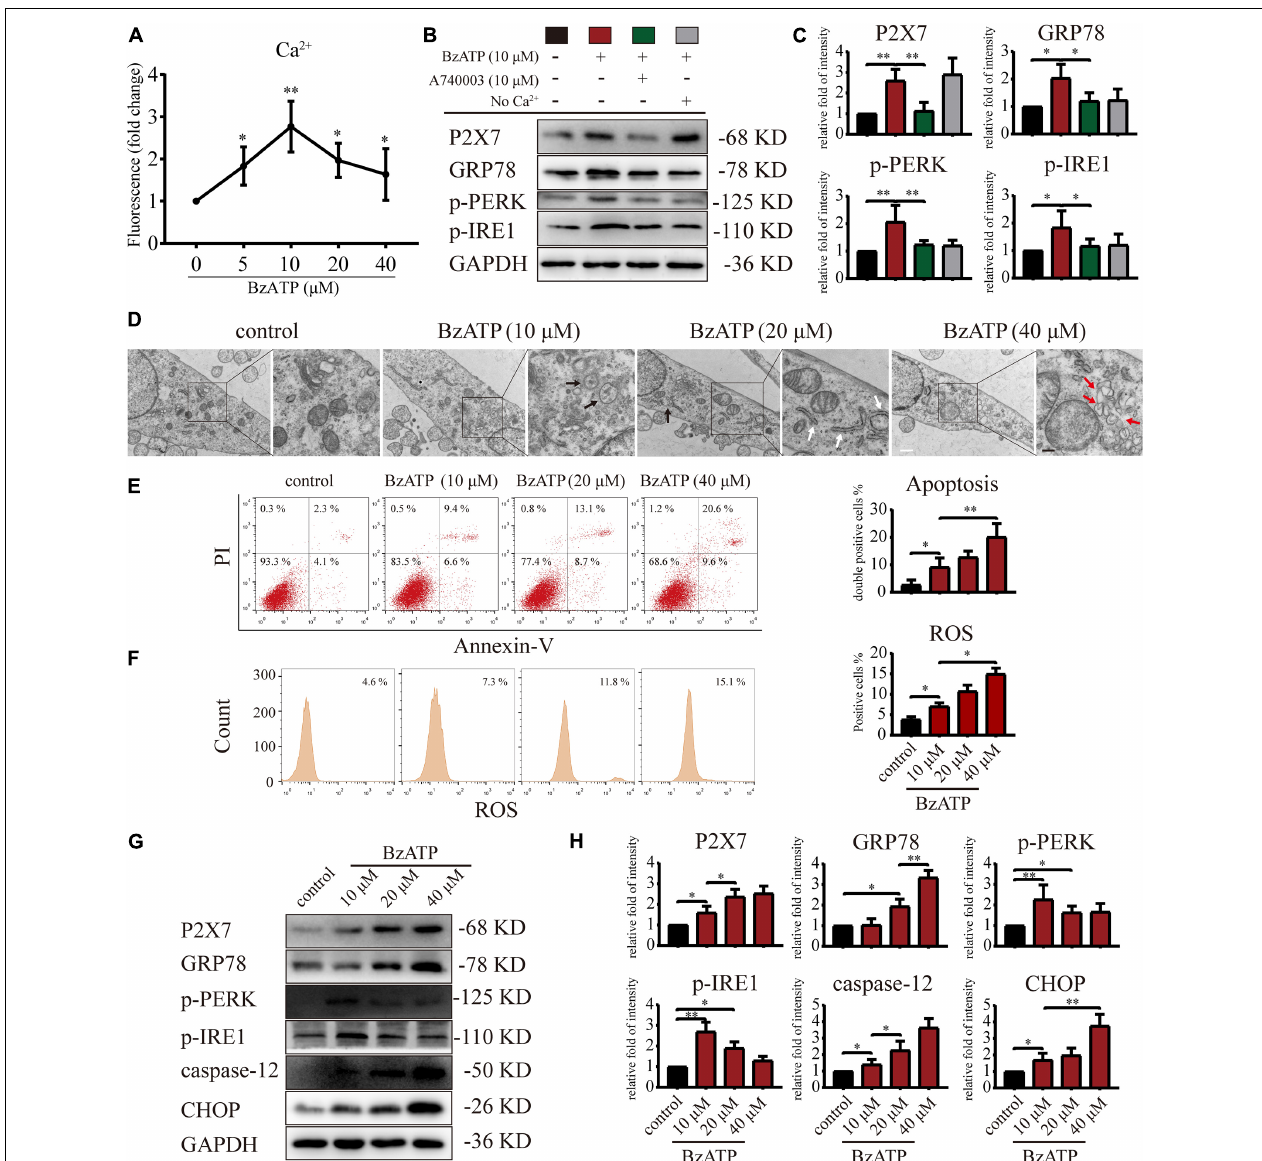
FIGURE 3 | P2X7 activation triggers Ca 2 + overload and induces ER stress. (A) Cells were cultured with different concentrations of Bz-ATP (0, 5, 10, 20, and 40 µ M), the fluorescence signal was detected by the microplate reader, and the Ca 2 + content in the ER was determined. (B,C) Cells were cultured with 10 µ M Bz-ATP, 10 µ M A740003, or Ca 2 + -free medium as described in section “Materials and Methods.” Western blotting was used to detect the protein levels of P2X7, GRP78, PERK, and IRE1. (C) Quantification of western blotting results. (D) Cells were cultured with different concentrations of Bz-ATP (0, 10, 20, and 40 µ M) as described in section “Materials and Methods,” and TEM was used to evaluate cell morphology and subcellular structures (black arrows: autolysosomes; white arrows: the expansion of ER; red arrows: vesicles; white bar: 2 µ m. black bar: 1 µ m). (E–F) To detect the proportion of apoptotic cells and the level of oxidative stress, cells were stained with Annexin-V/PI and ROS and analyzed by flow cytometry. (G,H) Cells were cultured with different concentrations of Bz-ATP (0, 10, 20, and 40 µ M), and the protein levels of P2X7, GRP78, p-PERK, p-IRE1, caspase-12, and CHOP were detected by western blotting. (H) Quantification of western blotting results. Data are expressed as means ± standard deviations of at least three independent experiments. ∗ p < 0.05, ∗∗ p <